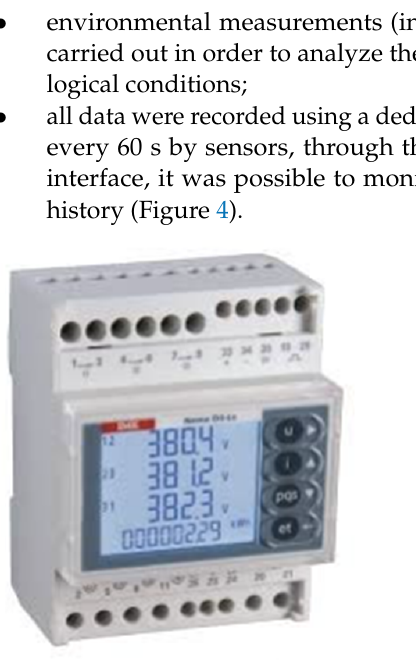
Figure 2. Acquisition system for the electrical energy measurements IME—NEMO D4.